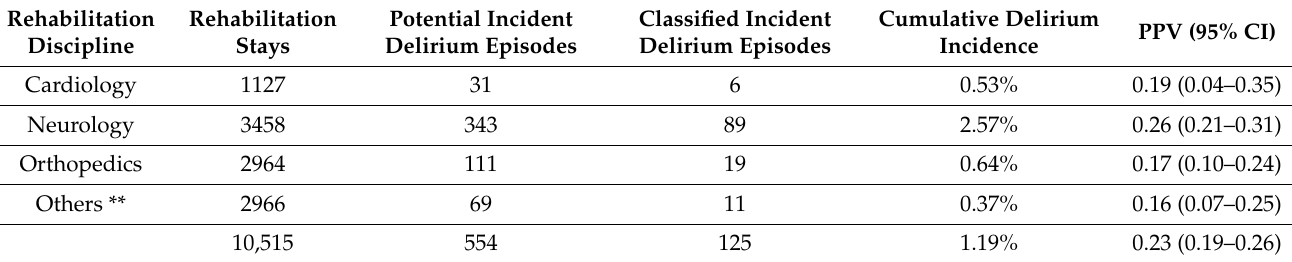
Table 4. Number of rehabilitation stays, potential and confirmed incident delirium episodes, cumulative delirium incidence and positive predictive values (PPV) with 95% confidence intervals (95% CI) by rehabilitation discipline and